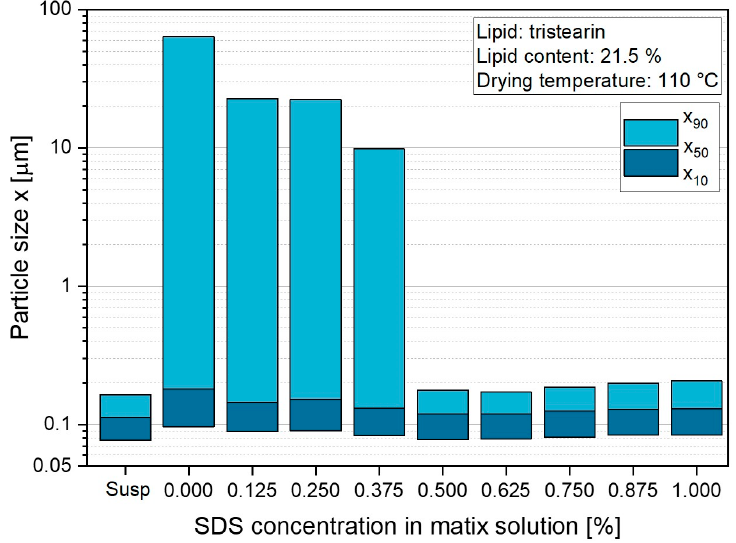
Figure 2. Influence of the SDS concentration in the lactose matrix solution as reflected by the size of the tristearin particles redispersed from the dried powders compared to that of the suspension (susp) before drying.